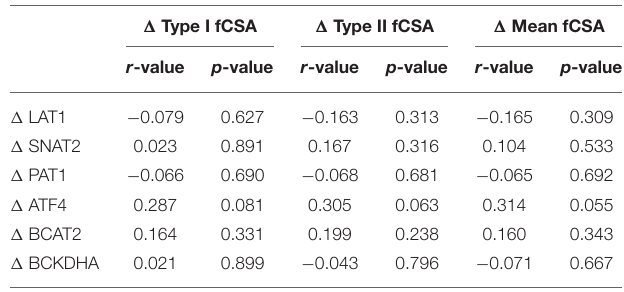
TABLE 4 | Correlations for the change in fCSA and the fold change in